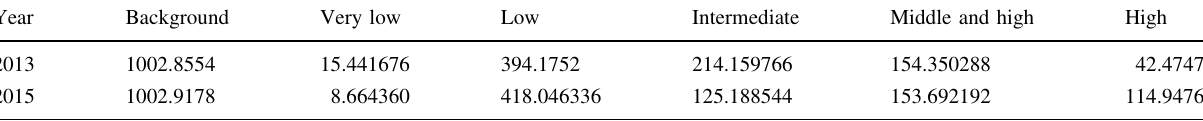
Table 3 Various types of vegetation changes in circumstances (km 2 ) Year